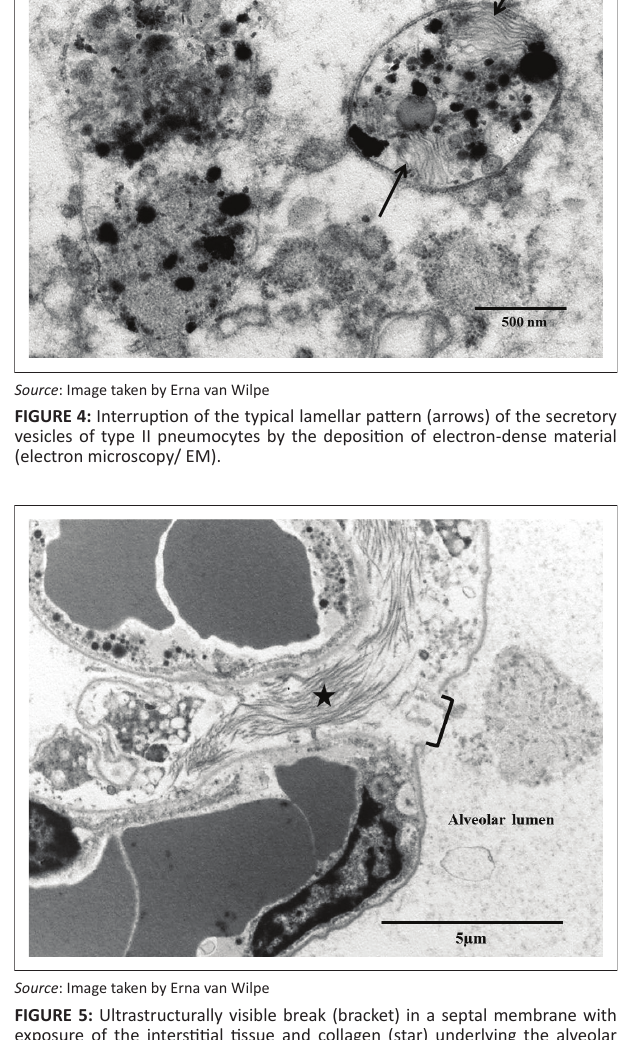
FIGURE 5: Ultrastructurally visible break (bracket) in a septal membrane with exposure of the interstitial tissue and collagen (star) underlying the alveolar lumen.